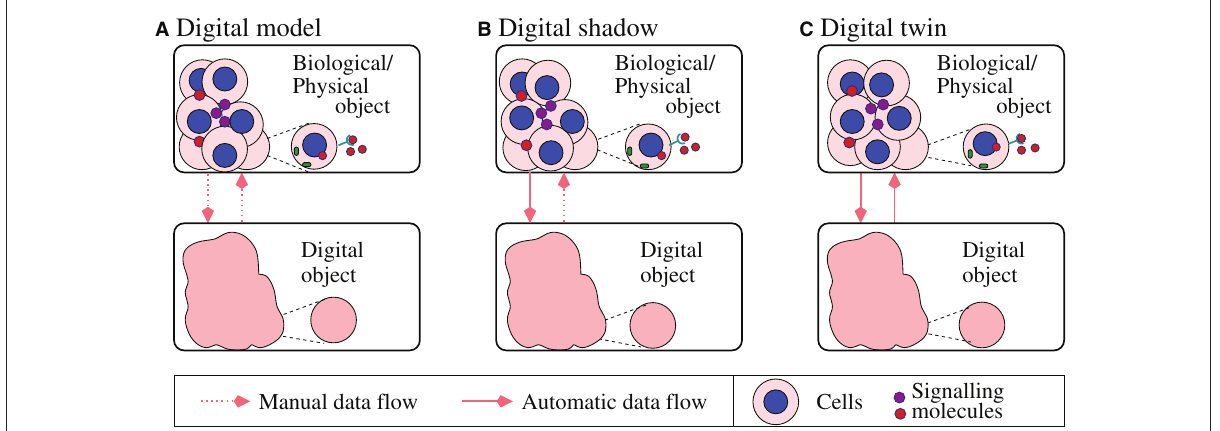
FIGURE2 Summary of three sub-categories of digital objects proposed in Kritzinger et al. [50] and adapted here to biological systems: (A) digital model; (B) digital shadow; (C) digital twin. The diagram shows a caricature description of various cell–cell interactions (at cell/tissue levels) and a zoom-in on a single cell and protein dynamics inside this cell (at molecular-level), to emphasize the multi-scale aspect of some of these biological digital